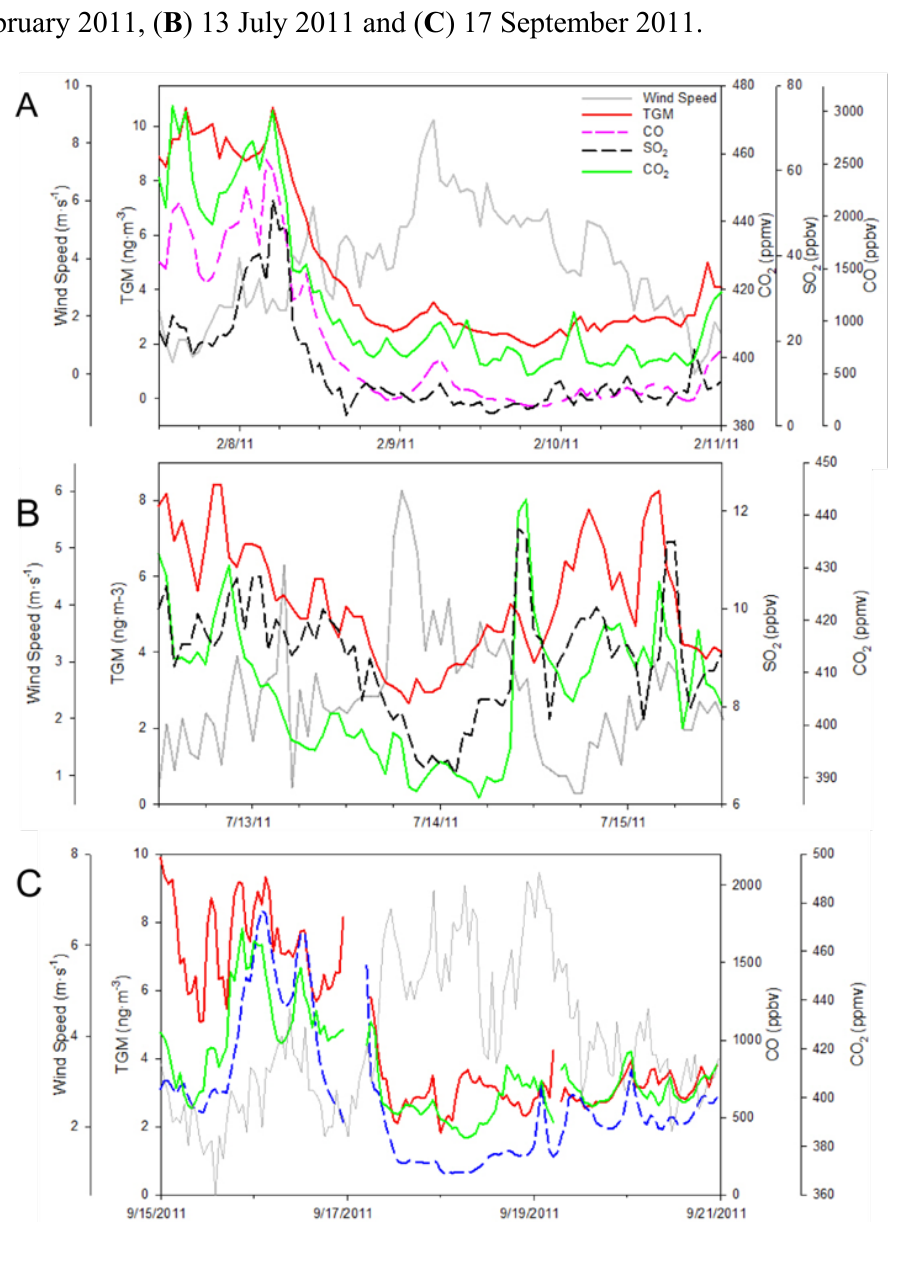
, and SO , together with wind speed on 2 2